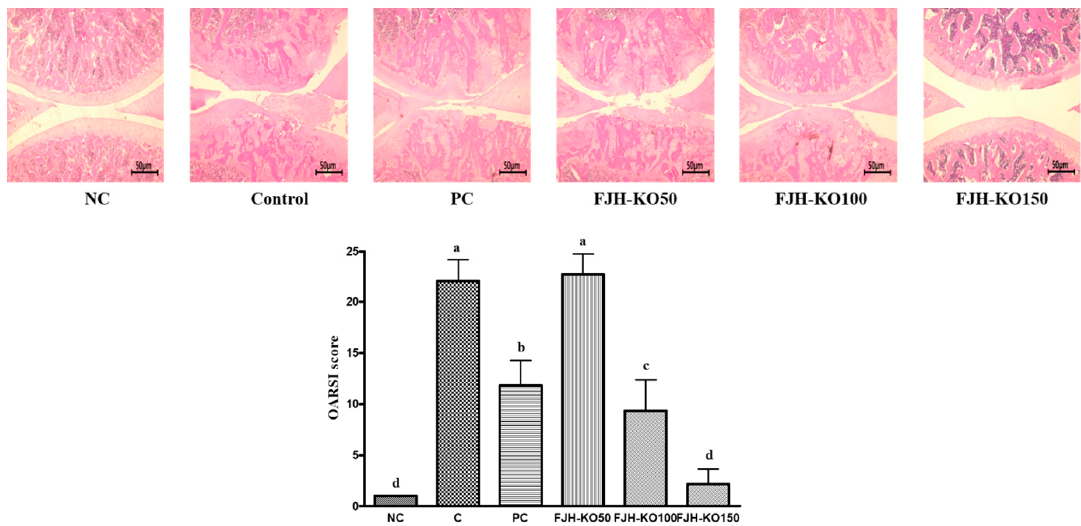
Figure 1. H&E staining in the knee joints of normal rats and osteoarthritic rats. NC: AIN93G diet; C: